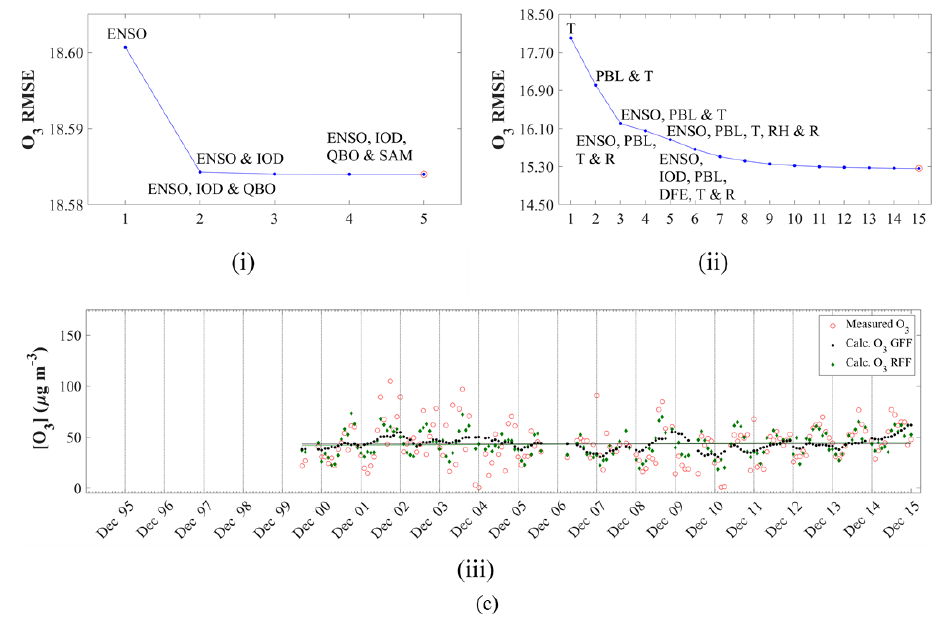
Figure 11. (i, ii) RMSE differences between modelled and measured O 3 concentrations as a function of the number of independent variables included in the model, as well as a comparison between modelled and measured O 3 levels (iii) for global force factors only (GFF) and for global, regional and local factors (RFF) determined for AF (a) , LT (b) and SK (c) .